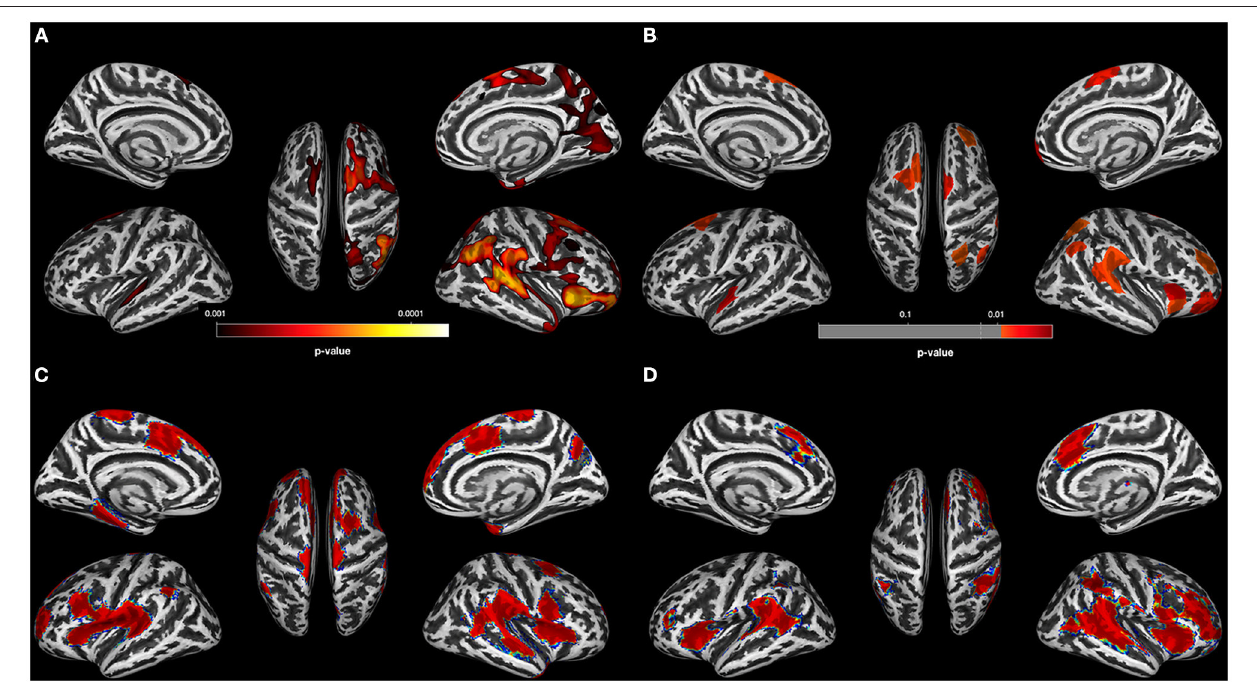
FIGURE 2 | Results for OUD individuals. (A) Results of the data-driven vertex-wise cortical thickness (CT) analysis—controls have significantly higher CT values than opioid use disorder individuals (OUD) at p = 0.001 FWE corr. (TFCE). (B) Results of the data-driven ROI analysis with the Schaefer Atlas ( 48) (200 parcels) colored are ROIs for which controls have significantly higher mean CT values than OUD at p = 0.01 FDR corr; (C) CT covariance results, highlighted with red are all Schaefer ROIs with which the two ROIs corresponding to the two peak vertices of the most significant clusters in (A) show significant positive correlations at p < 0.05. (D) Result of the Neurosynth seed correlation analysis (thresholded at r > 0.2) with resting-state data of 1,000 healthy participants with the MNI coordinates of the two peak vertices of the most significant clusters in (A) as